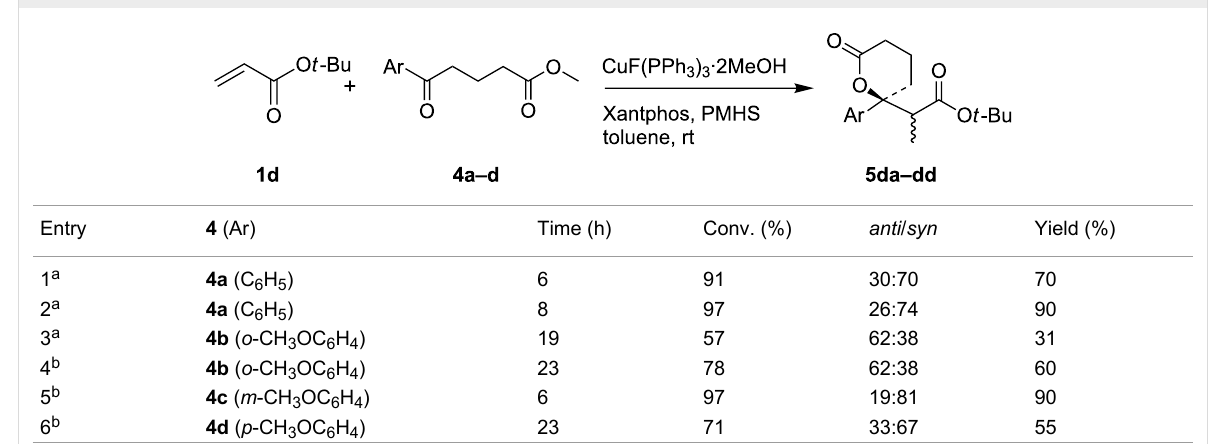
Table 5: Reactions of 5-oxopentanoates with tert -butyl